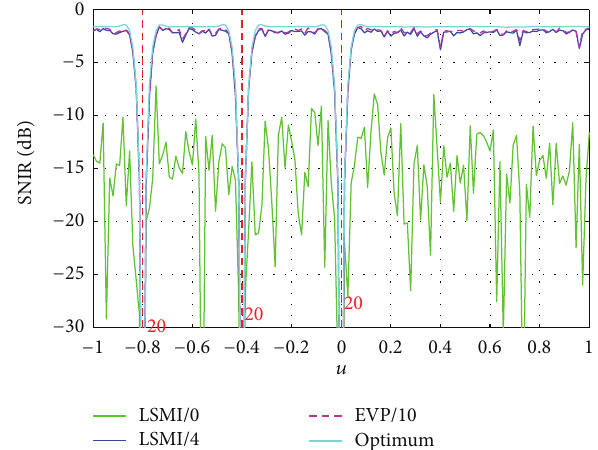
Figure7:SNIRforSMI,LSMI( 𝛿 = 4𝜎 2 ),andeigenvectorprojection with dim (JSS) =